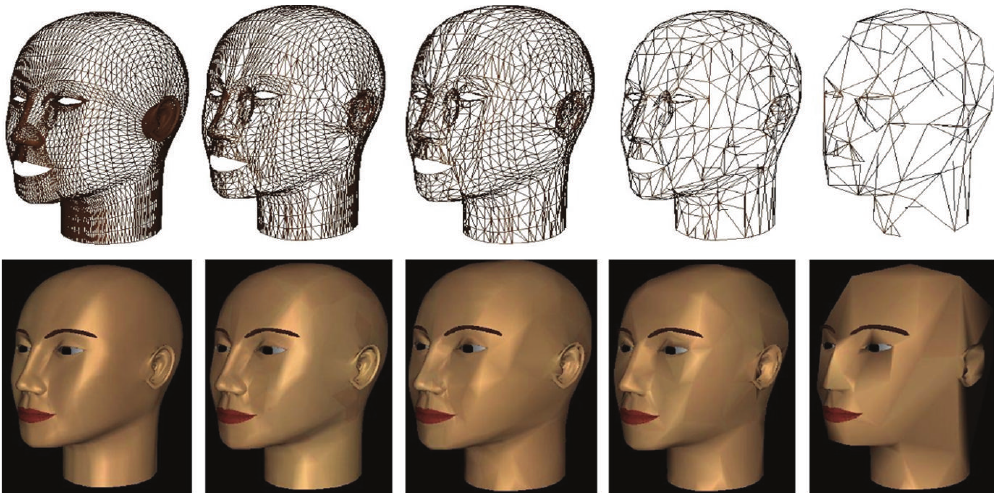
Figure 6: QoS variation for 3D application by polygons reduction [7].